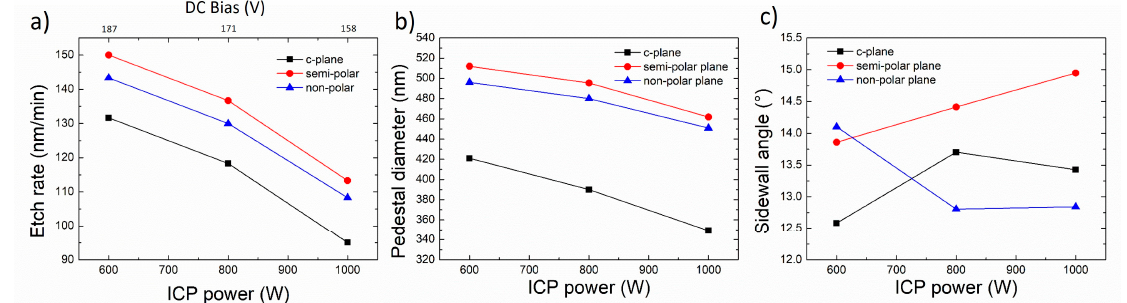
Figure 12. ( a ) Etch rate, ( b ) base diameter and ( c ) sidewall angle of c -plane. (1122) semi-polar and (1120) non-polar GaN layers as a function of ICP power.